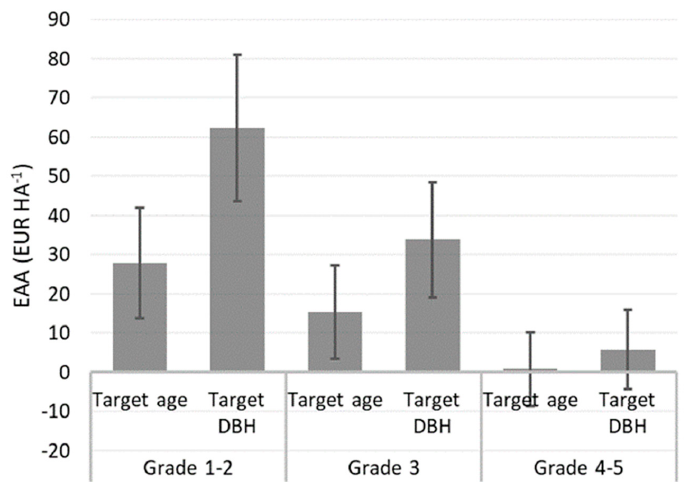
Figure 4. Average equal annual annuity (EAA, EUR ha − 1 ) applying 2%, 3% and 4% interest rates for different needle cast damage groups at two final harvest scenarios: cutting according to target age (101 years) or when the minimum allowable diameter at breast height (DBH) is greater than or equal to 35 cm. Whiskers denote 95% confidence intervals.